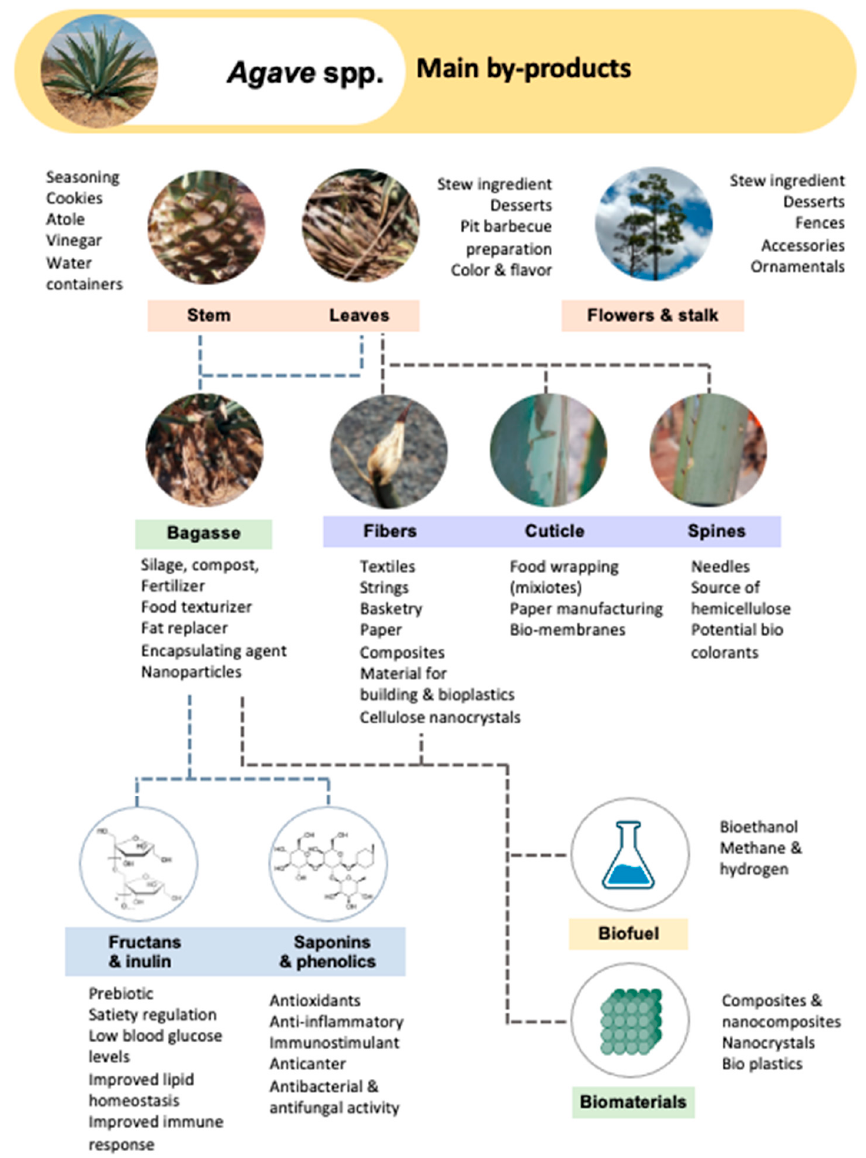
Figure 1. Most relevant by-products obtained from the agave plant and some reported uses. Spines and stalks, although exploited to a lesser extent, represent an interesting source of bioactive compounds, bio colorants, and fibers for the textile industry, and could be a substrate for saccharification [35,36]. The cuticle, also denominated “mixiote”, is the outer waxy membrane that covers the surface of agave leaves (Figure 1), protecting the plant from environmental conditions. Traditionally, the cuticle is used for wrapping meat preparations in Mexican cuisine and for paper manufacturing [37,38]. A recent publication has shown the value of the cuticular material as a proton-exchange bio-membrane integrated into an electrolyzer and fuel cells [38]. In summary, by-products from the agave plant have great applications in the energy and environmental sectors, as well as potential as functional ingredients for food prod- ucts.